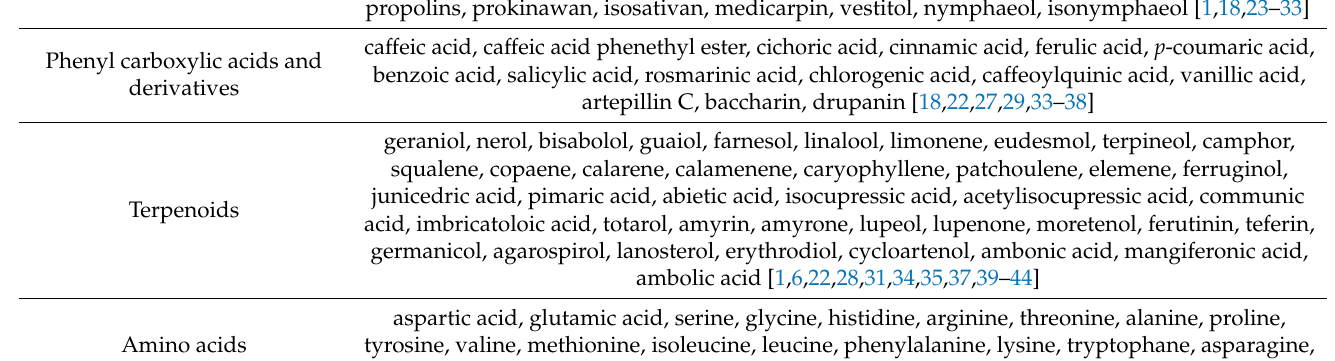
Table 1. Main chemical compounds present in the composition of honeybees and stingless bees propolis.